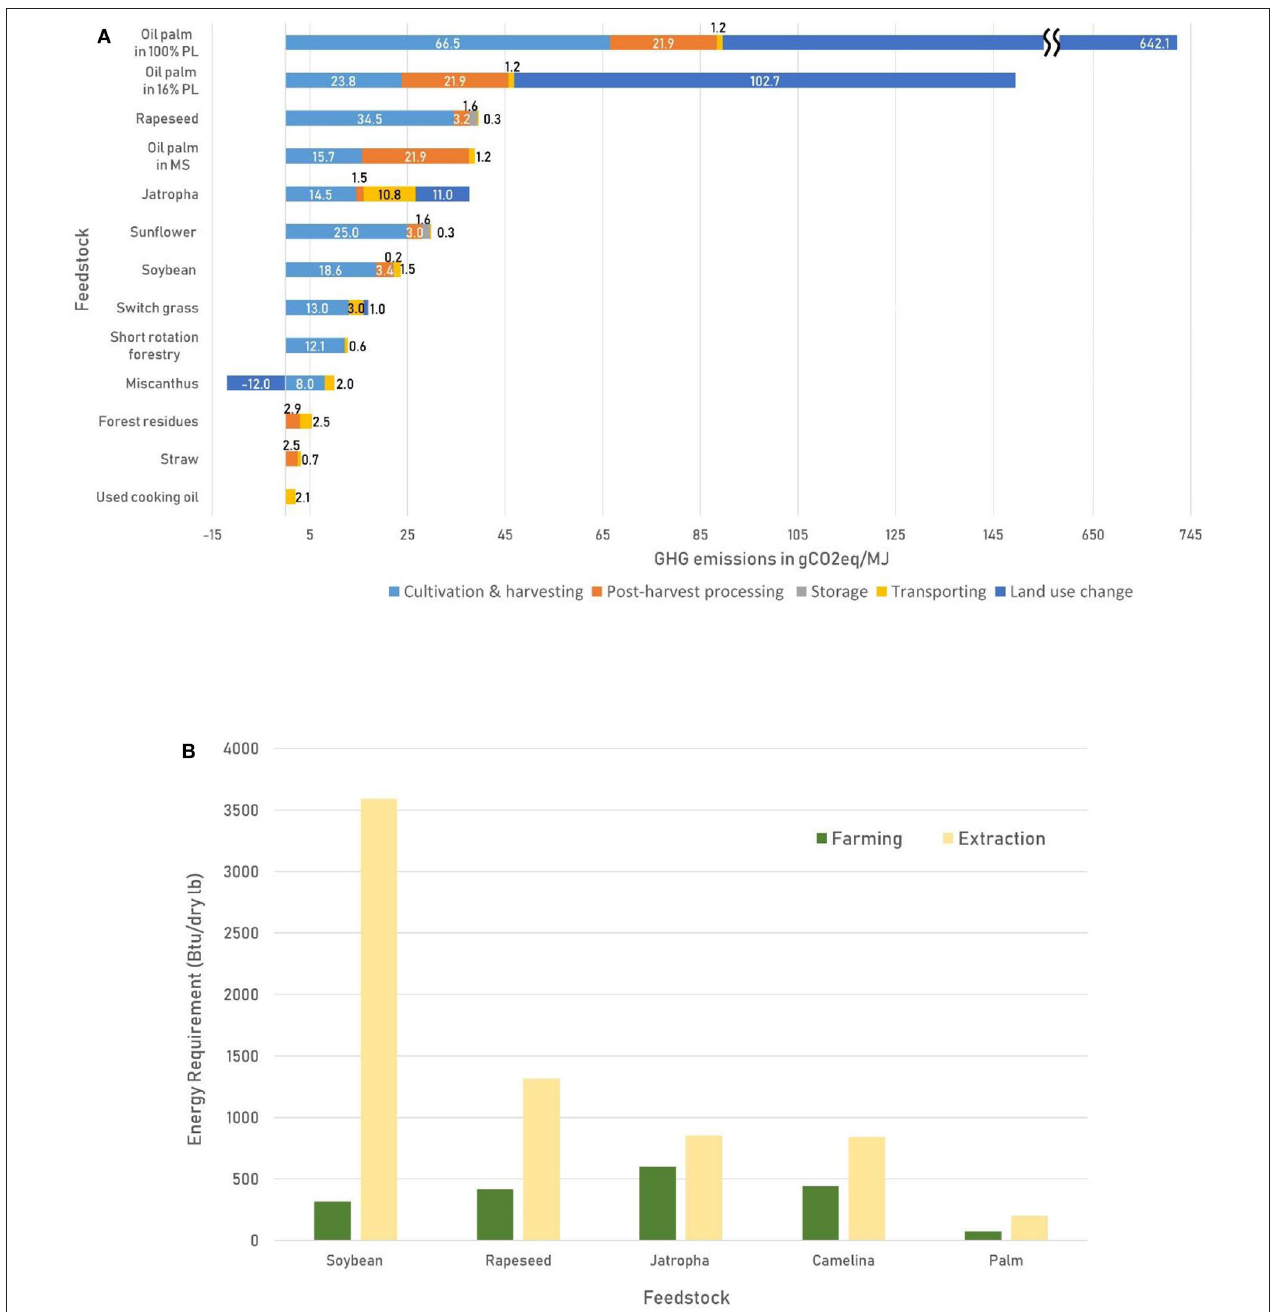
FIGURE 4 | Typical environmental impacts of some 1-G and 2-G feedstocks for BAF production: (A) Farm-to-gate GHG emissions (Plotted using data from Bailis and Baka, 2010; Wang et al., 2012; Velazquez Abad et al., 2015; O’Connell et al., 2019); and (B) Energy requirements for farming and extraction of some oil-seed crops (Plotted using data from Elgowainy et al.,